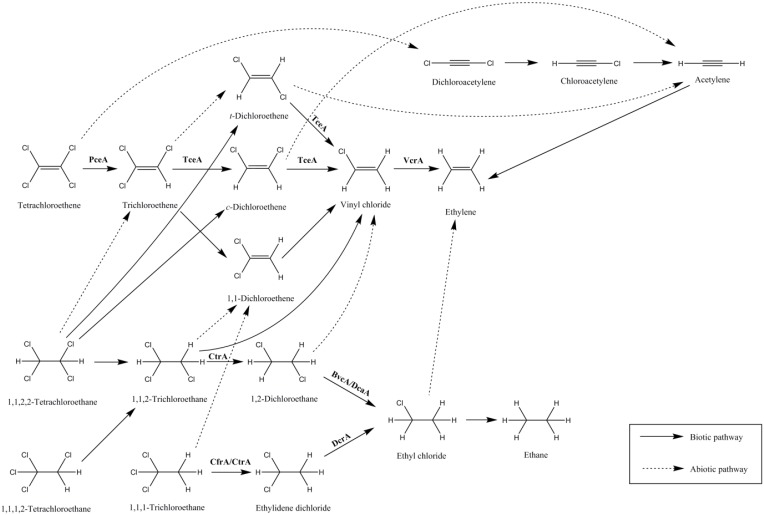
Dechlorination of chlorinated ethenes and ethanes via anaerobic biotic and abiotic pathways. Examples of enzymes catalyzing the biotic reactions are given: PceA (Miller et al., 1998), TceA (Magnuson et al., 2000; Fung et al., 2007), VcrA (Parthasarathy et al., 2015), CtrA (Zhao et al., 2015), BvcA (Tang et al., 2013), DcaA (Marzorati et al., 2007), CfrA (Tang and Edwards, 2013), CtrA (Ding et al., 2014), and DcrA (Tang and Edwards, 2013).